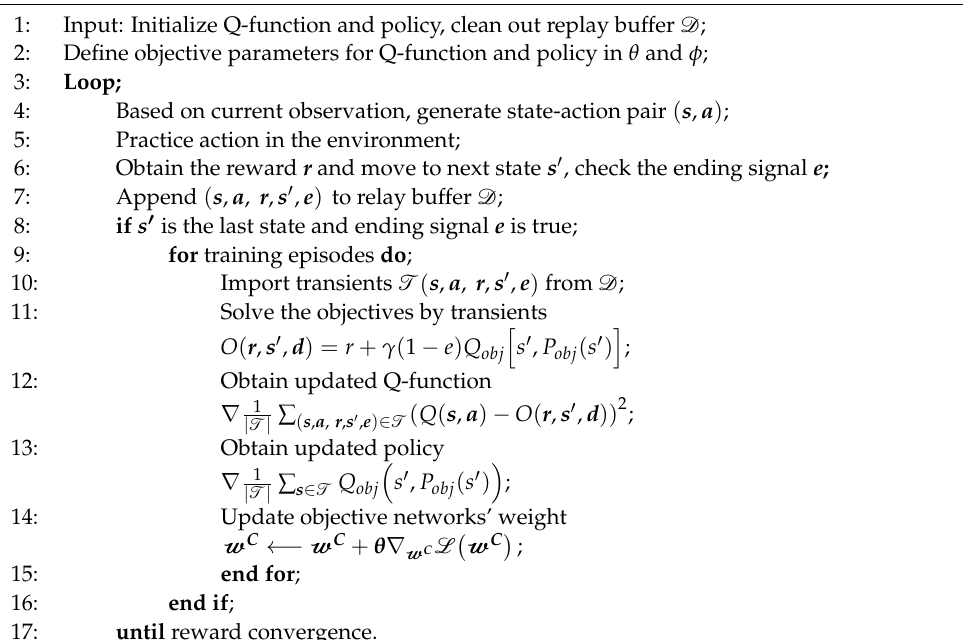
Algorithm 1 Deep deterministic policy